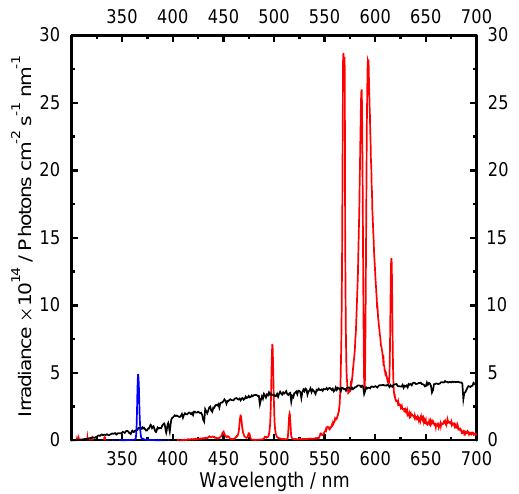
Fig. 3. Total irradiances for the VIS and UV irradiation sources as a function of lamp distance from the organic substrate are shown as closed and open circles, respectively. The open circles refer to the right y-axis. Error bars denote 1 σ of the mean irradiance and the mean distance.